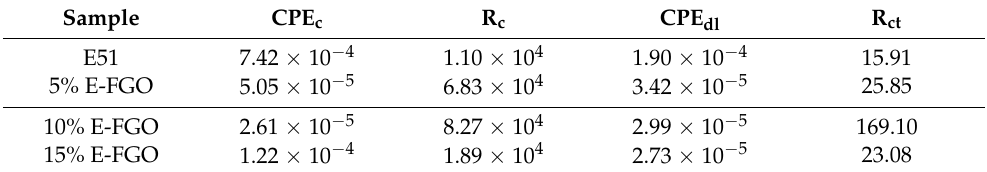
Table 1. Electrochemical parameters for E51 and E-FGO coatings in 3.5 wt% NaCl solution.